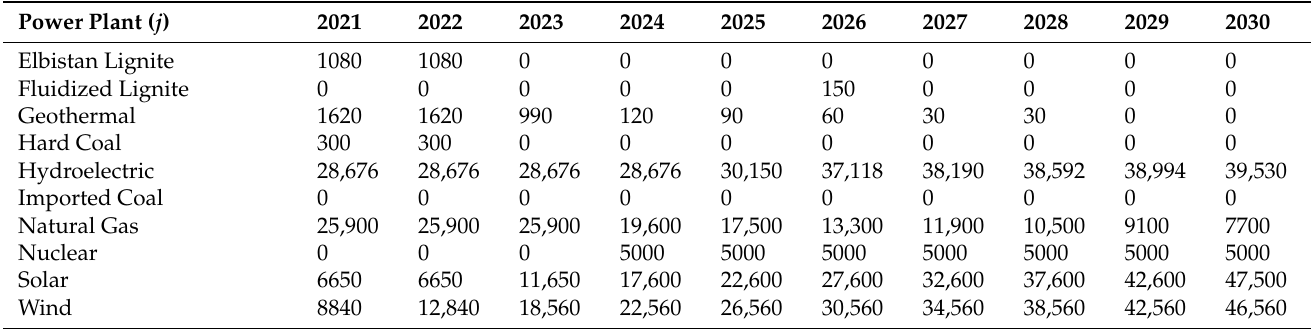
Table 3. Installed Capacities of Power Plants (MW) for the 2021–2030